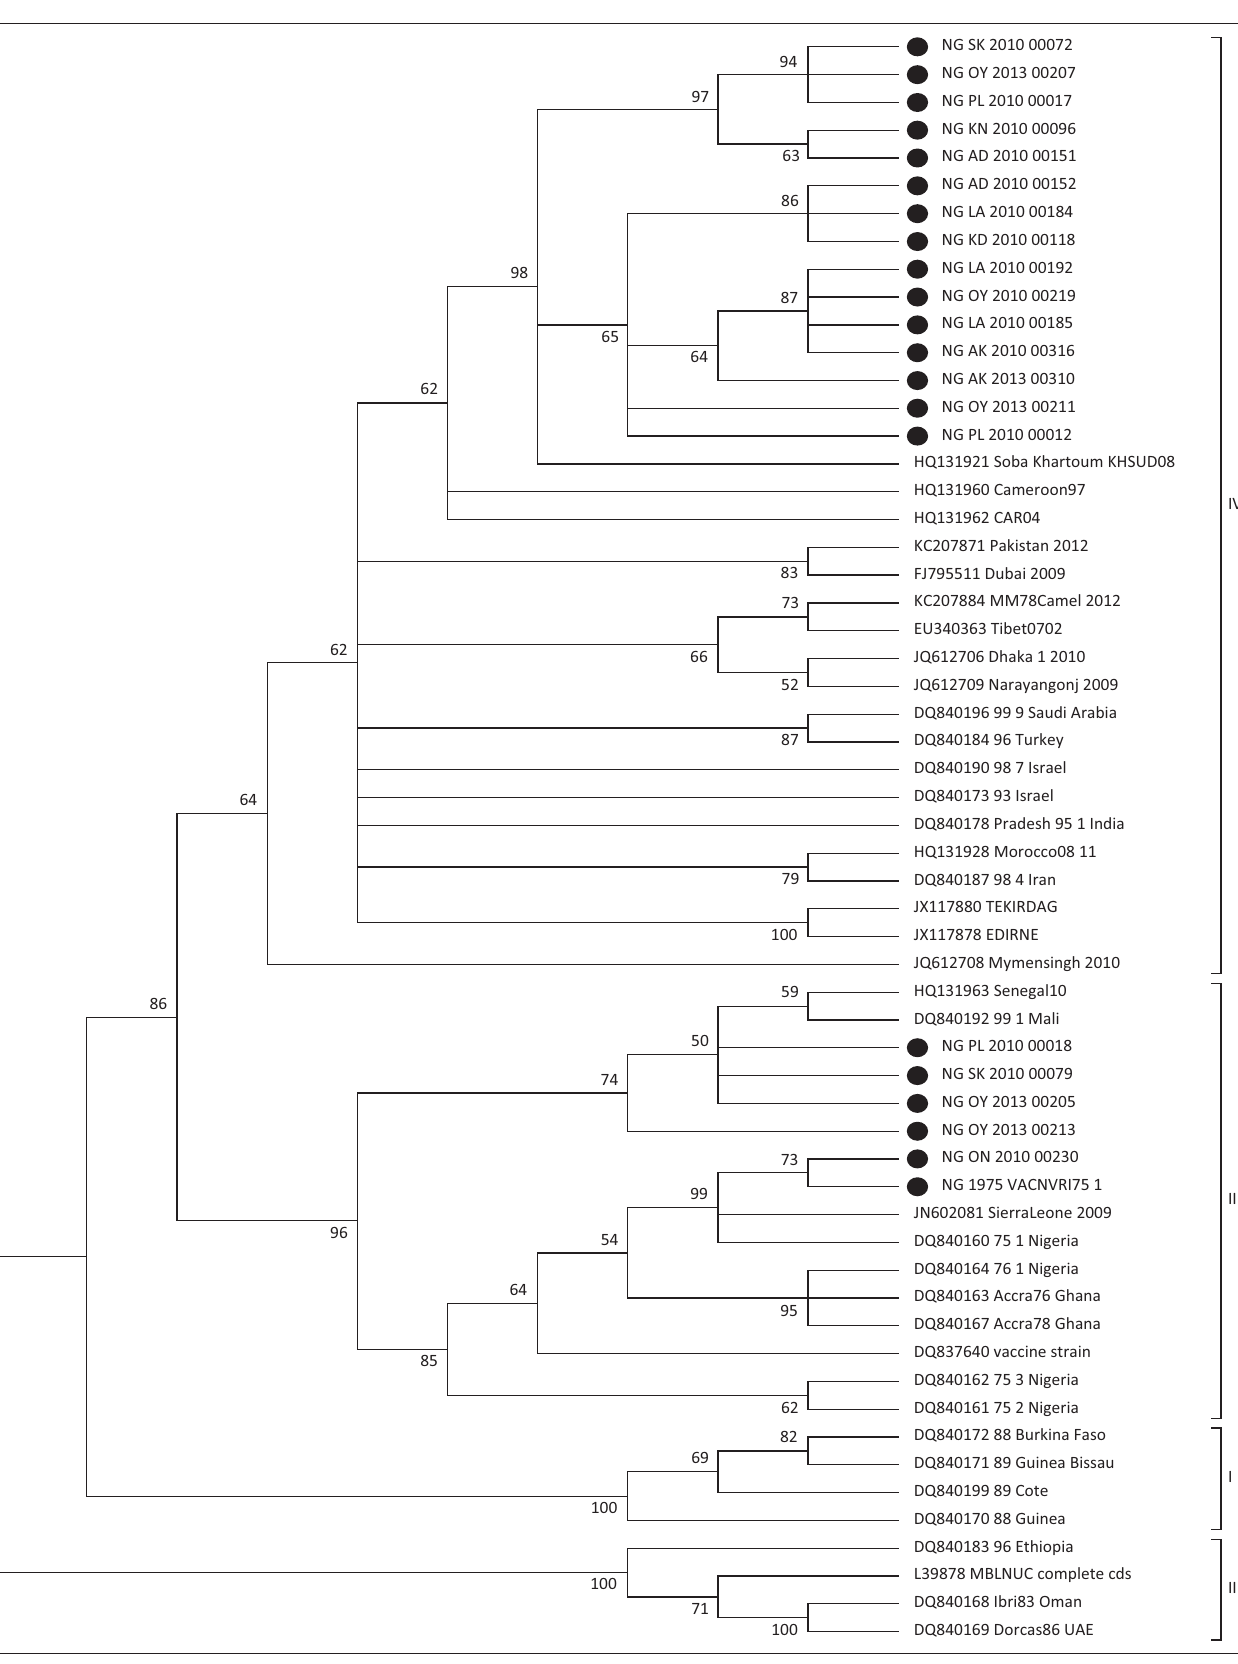
Novel Nigerian strains are indicated by filled circles. FIGURE 2: Fifty percent majority-rule consensus cladogram of partial unrooted peste-des-petits-ruminants virus N-gene sequences from this study and GenBank. The phylogeny was determined by distance analysis in Phylogenetic Analysis Using